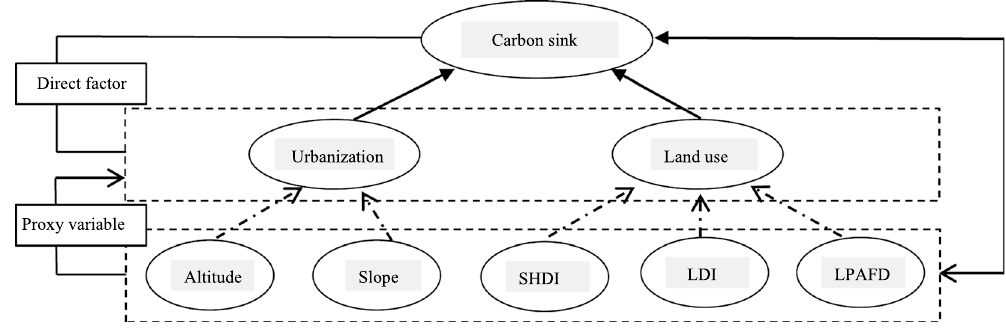
Figure 2. Proxy variable diagram (SHDI Shannon Landscape Diversity Index; LDI Landscape Dominance Index; LPAFD Landscape Perimeter Area Fractal